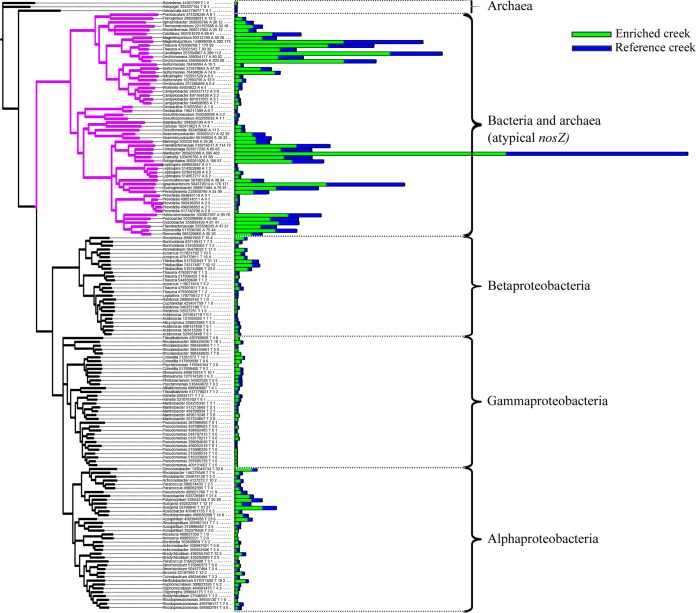
Bootstrapped neighbor-joining phylogeny of 158 nosZ sequence clusters from our original 240-reference NCBI-based database, representing 80 distinct bacterial and 3 archaeal genera. Clusters of >93% similarities were formed to reduce the total spread of the tree using UCLUST (47). Sequences in this tree had at least 1 hit from our creek sediment metagenomic data with an alignment bit score greater than 80. The number of hits from enriched and reference creeks to each cluster is shown by the length of the bar at the terminal node of each branch. Branches are colored by typical (gray) versus atypical (violet) genera according to categorization of atypical and typical genera by Sanford et al. in 2012 (17).